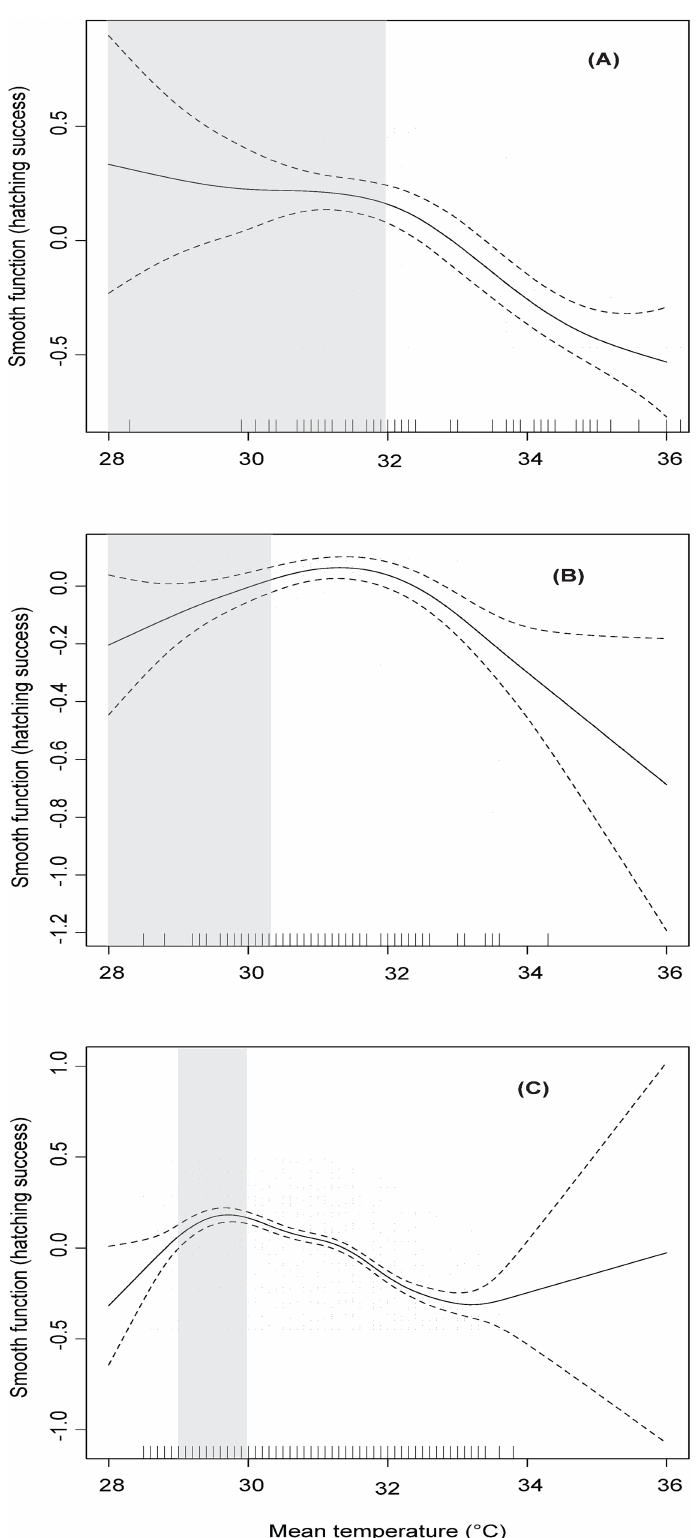
Fig 3. Smooth fits from generalized additive models (GAM) showing additive effect of nest temperature (˚C) on hatching success. (a) olive ridley turtle, (b) green turtle and (c) leatherbackturtle nests.